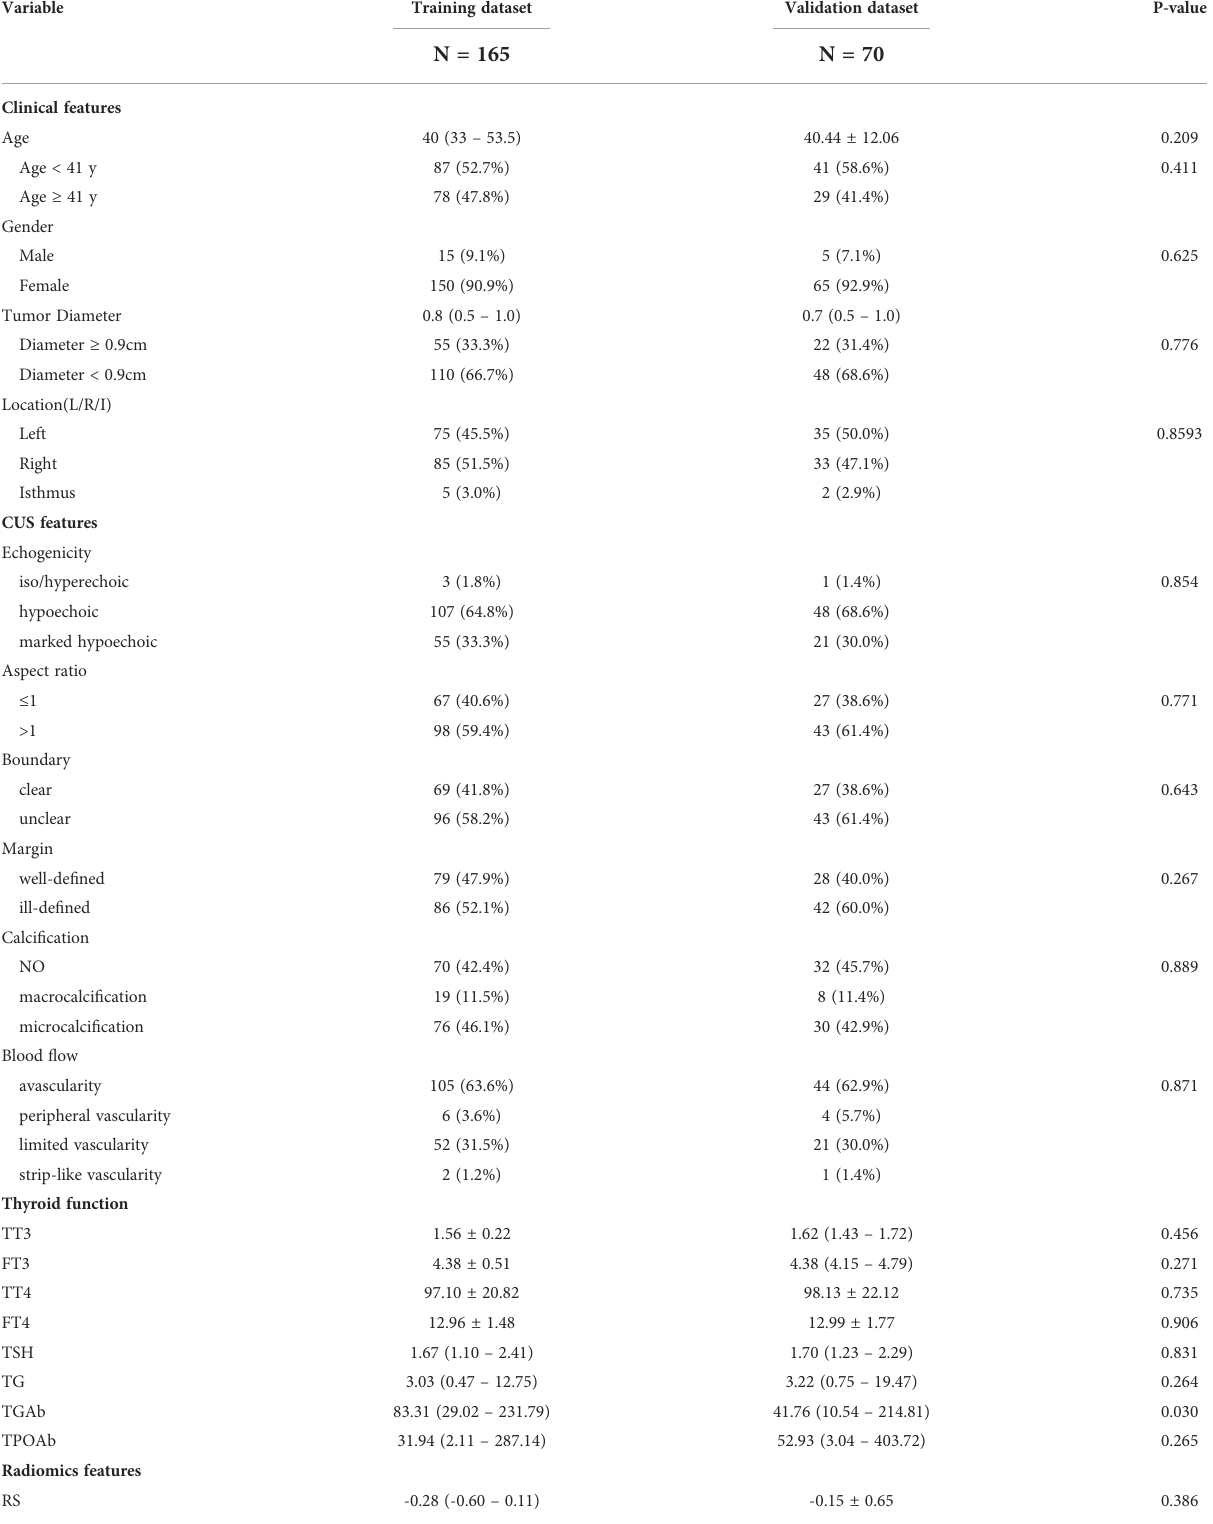
TABLE 2 Baseline clinical data in the training and validation